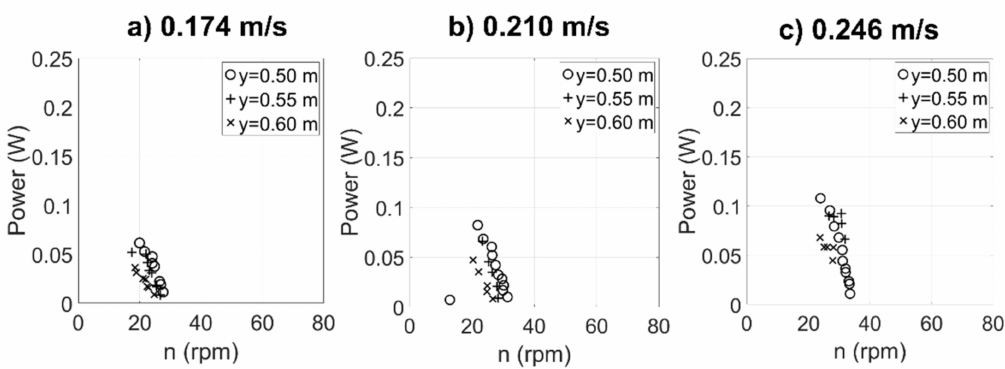
Figure 9. Variation of power vs. n for the different tests without an accelerator device.